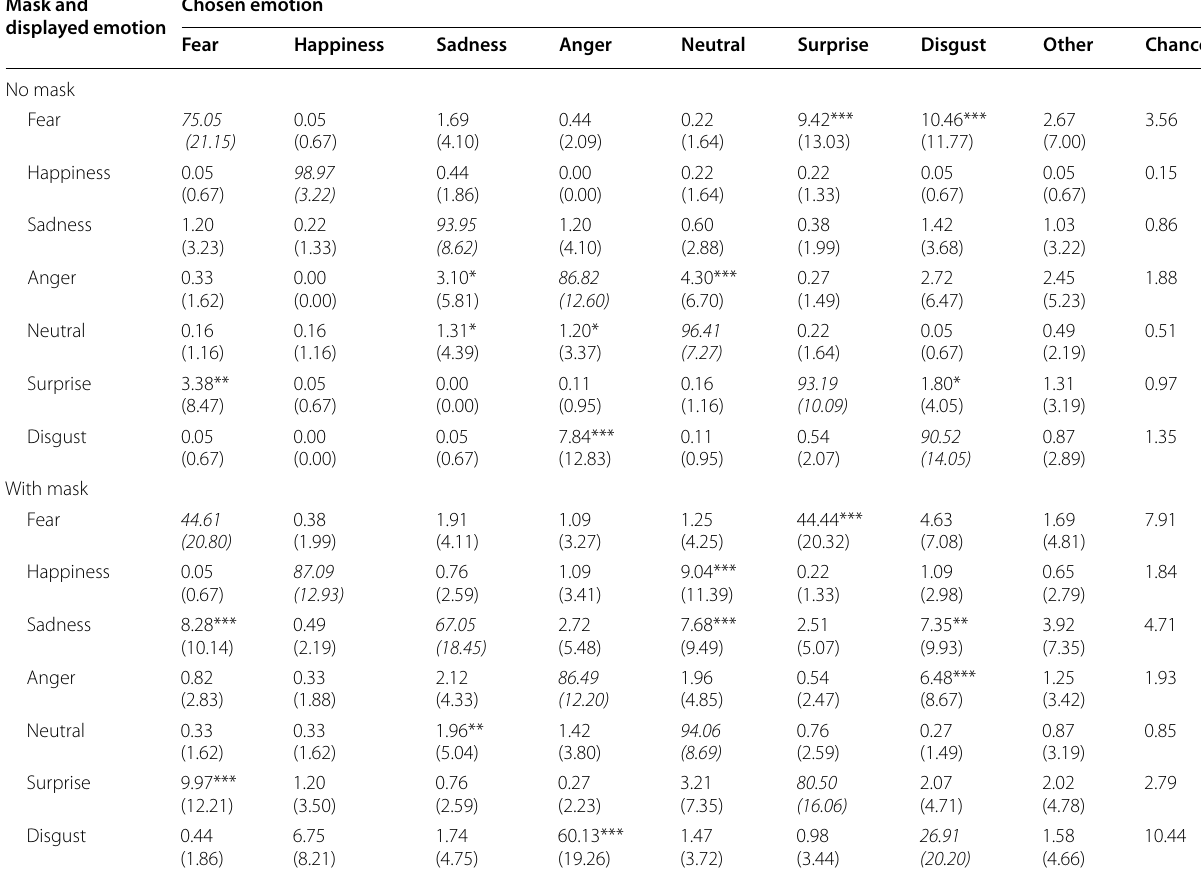
The cells show raw choice percentages instead of the analyzed arcsine transformed percentages. Hit rates are marked in italic. Asterisks indicate confusion percentages above the chance level shown in the right column (* p < .05, ** p < .01, *** p < .001). Chance levels refer to the distribution of confusions only, excluding the hits. Percentages are rounded to two digits and may not add up to exactly 100%